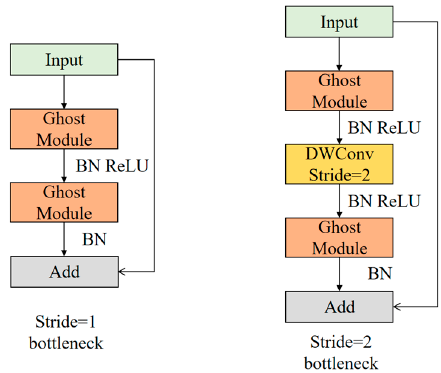
Figure 4. Structure of Ghost